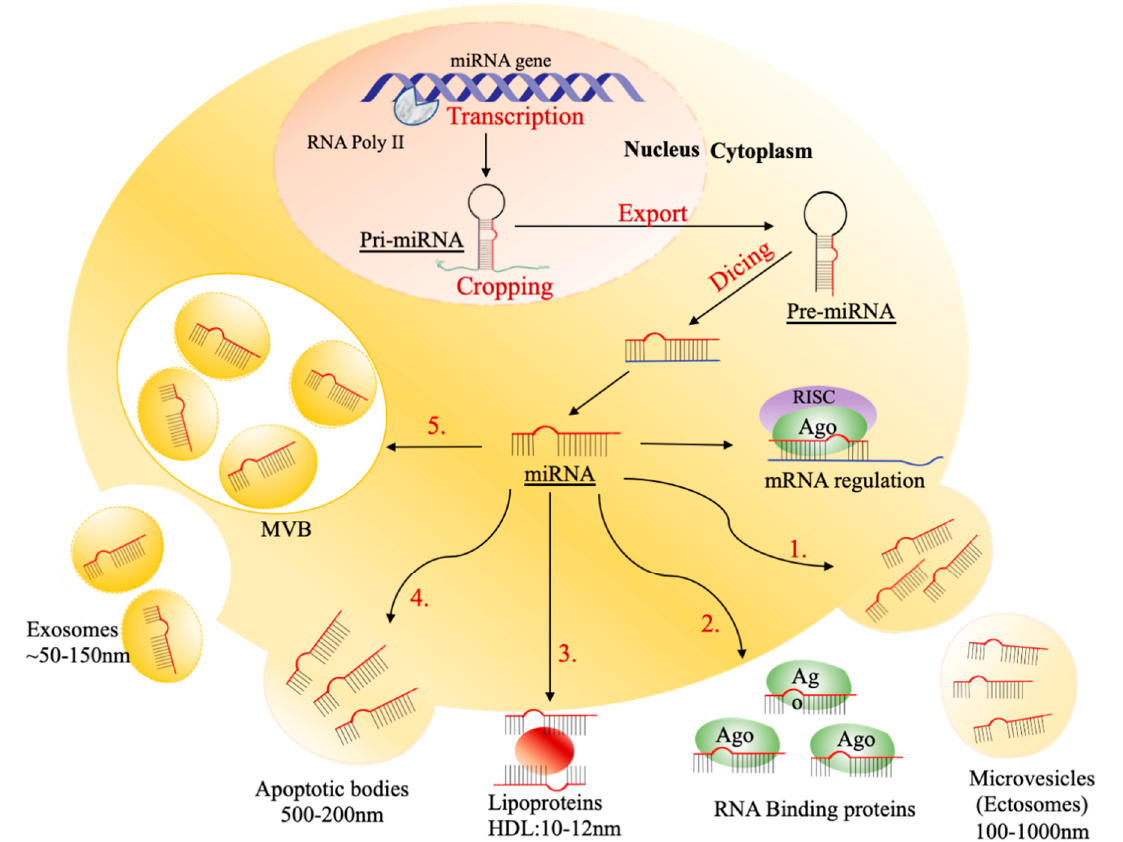
Figure 2. The mechanism of transporting circulating miRNAs. The process is initiated by transcription of the miRNA gene, cropping pri-miRNA, exporting pre-miRNA, and dicing to form a mature miRNA. The mature miRNA either regulates mRNA or is passaged into extracellular circulation. There are five different ways of passaging circulating miRNAs: (1) collecting in 500–200 nm of apoptotic bodies; (2) binding to Ago2 protein; (3) enveloping into 100–1000 nm of microvesicles (MVs), including ectosomes, (4) binding to 10–12 high-density lipoproteins (HDLs); (5) packaging into ~50–150 nm of exosomes.